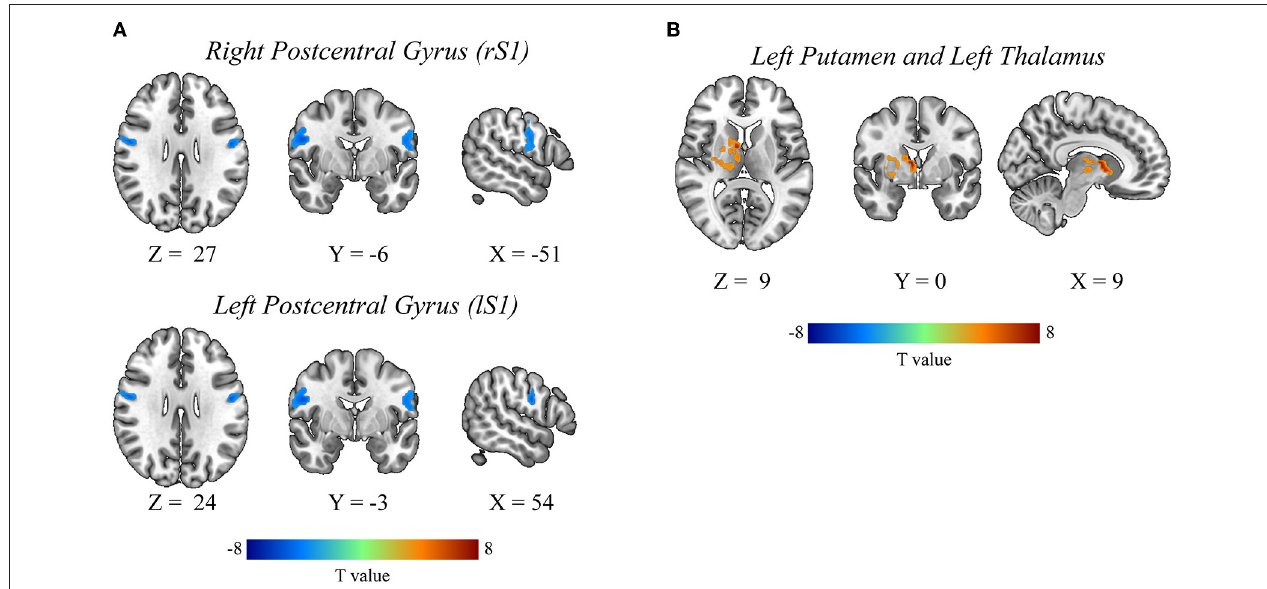
FIGURE 1 | The univariate differences in dALFF and sALFF between DCM patients and healthy controls. DCM, Degenerative Cervical Myelopathy; HC, Healthy Controls; sALFF, static amplitude of low-frequency fluctuation; dALFF, dynamic amplitude of low-frequency fluctuation. (A) The dALFF differences between DCM and HC. (B) The sALFF differences between DCM and HC.